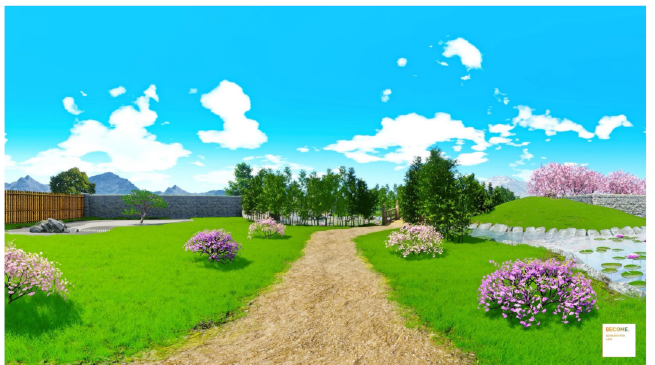
Figure 2. ‘The Secret Garden’, a 360 ◦ virtual reality scenario where participants are immersed in a naturalistic and safe digital place, far from the stressful situations experienced in routine daily contexts, in which they can learn how to relax and reflect upon their experience following a guided